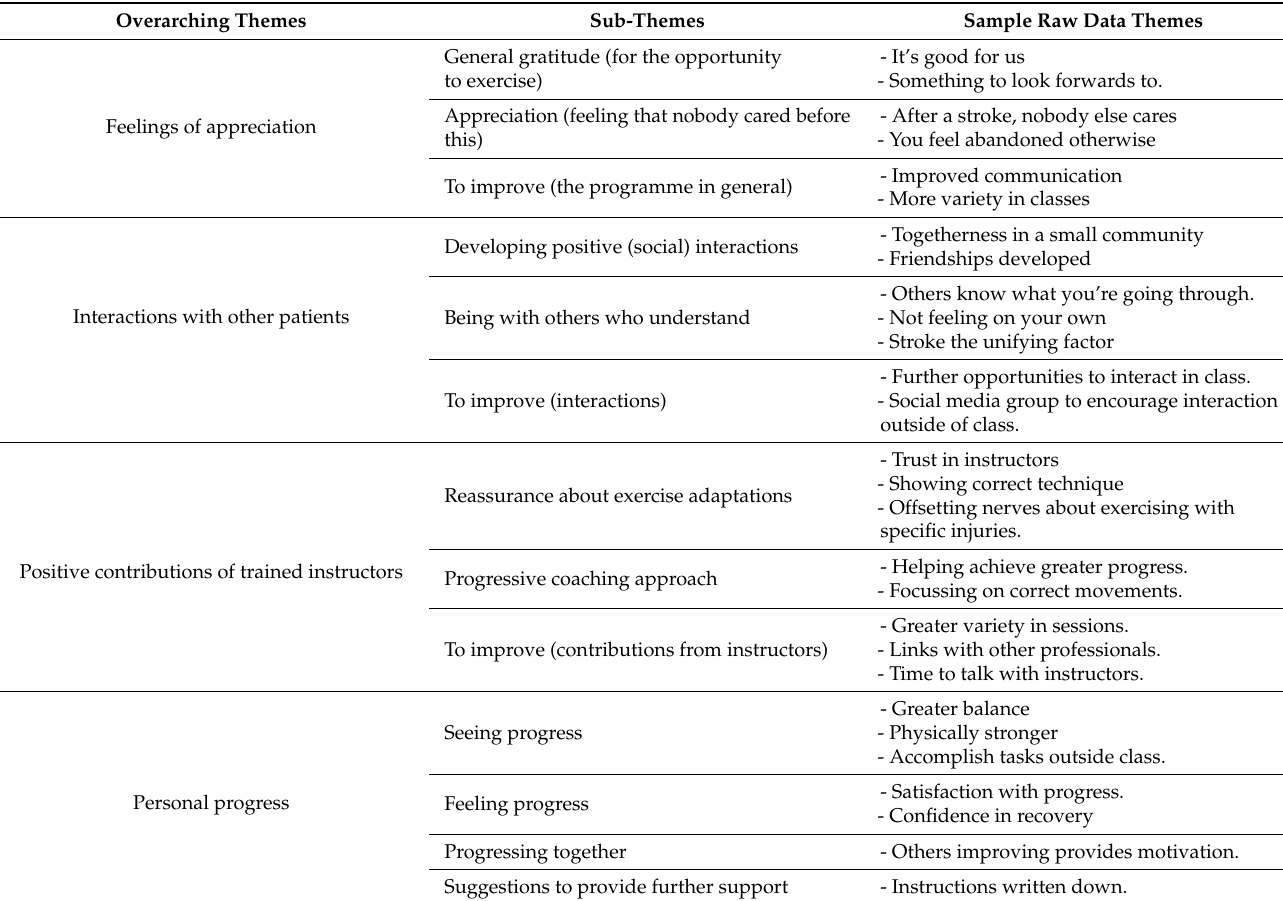
Table 2. Overarching themes, subthemes and sample raw data